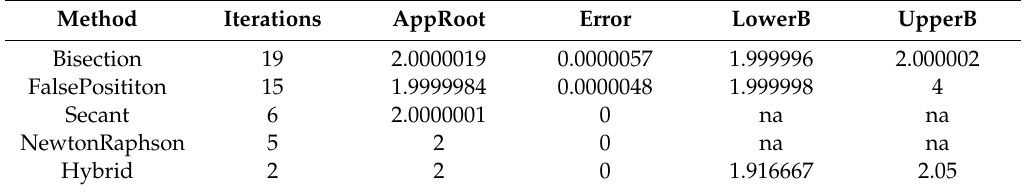
Table 1. Comparison of classical algorithms iterations, AppRoot, error and interval bounds.